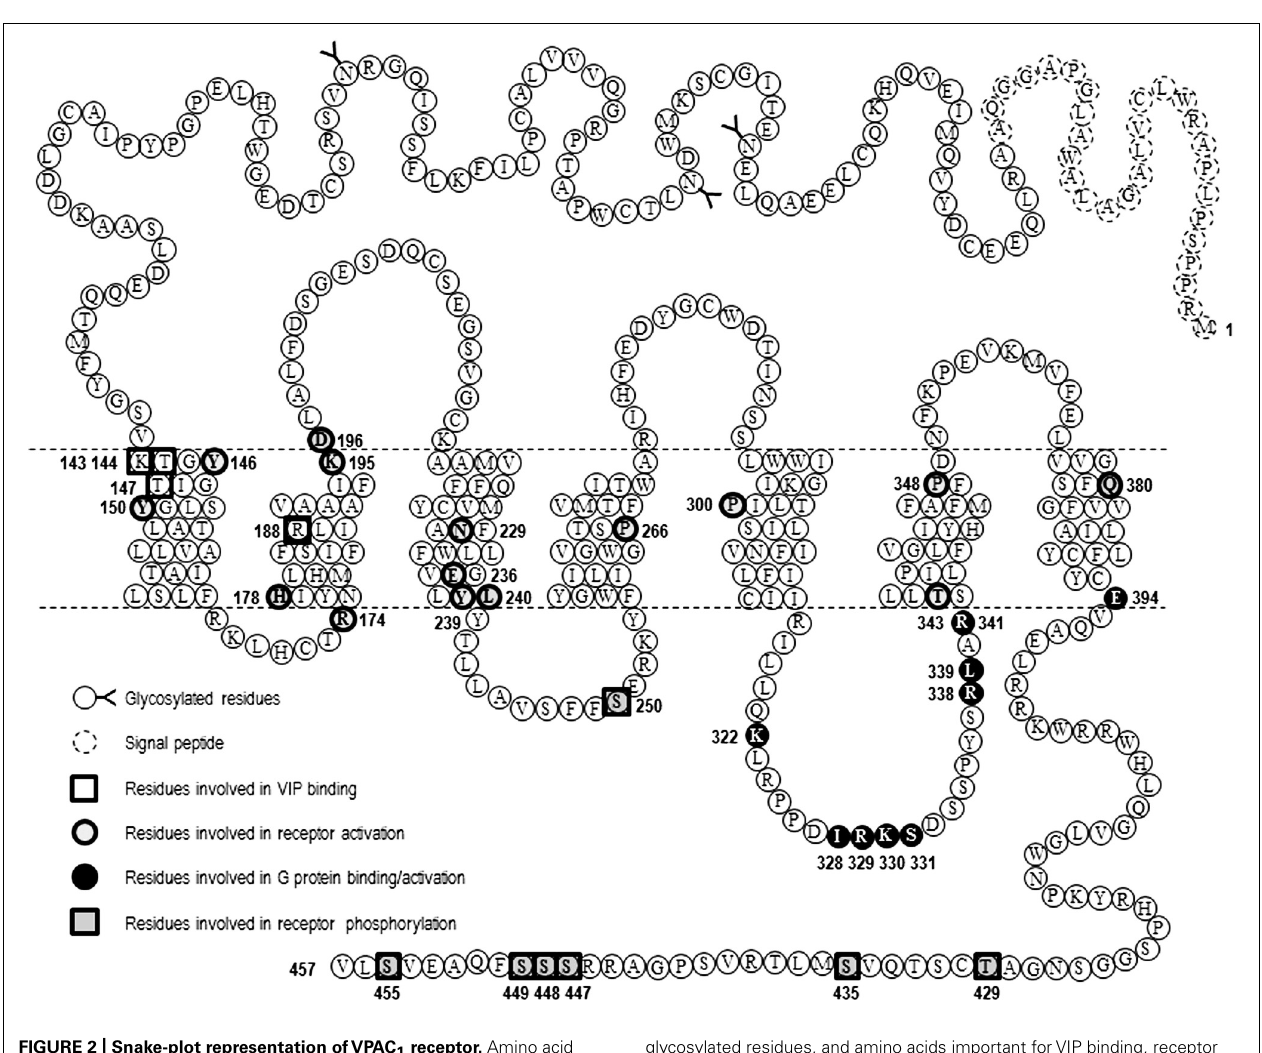
glycosylated residues, and amino acids important forVIP binding, receptor activation, and G protein coupling are also